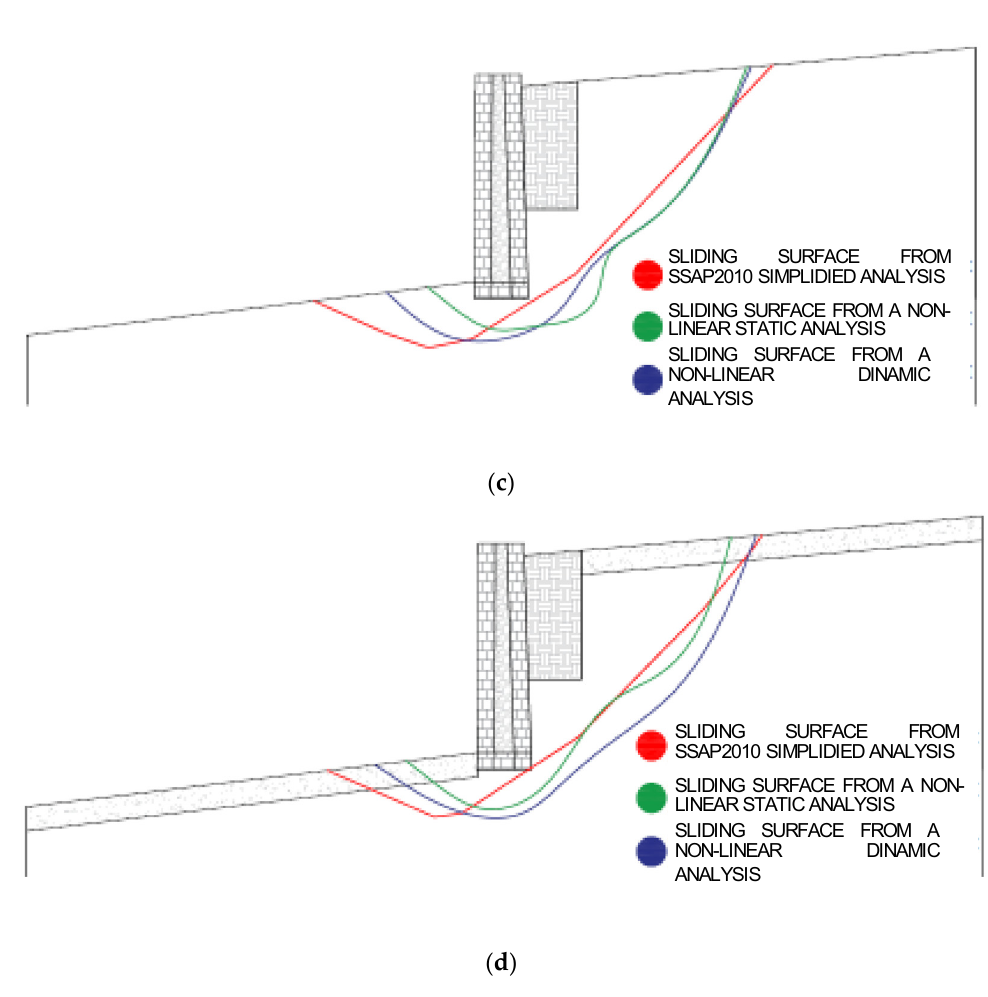
Figure 10. Failure surface of two representative sections for the standard ( a ) and ( c ) and modified sections ( b ) and ( d ).